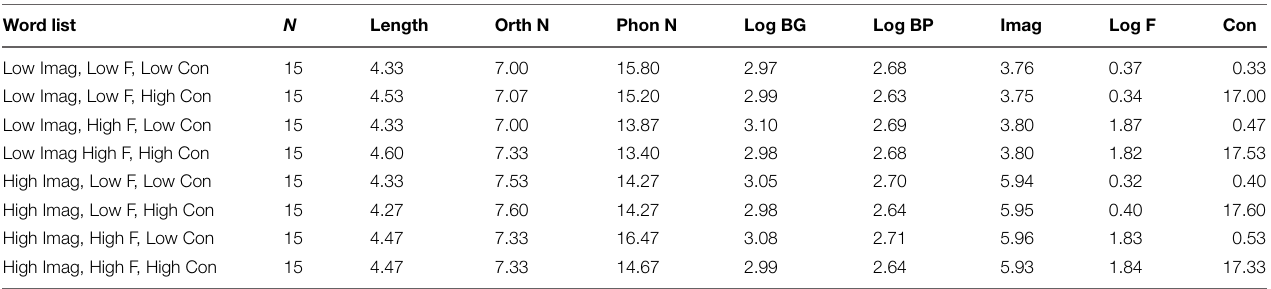
TABLE 2 | Linguistic measures of word stimuli in the reading aloud